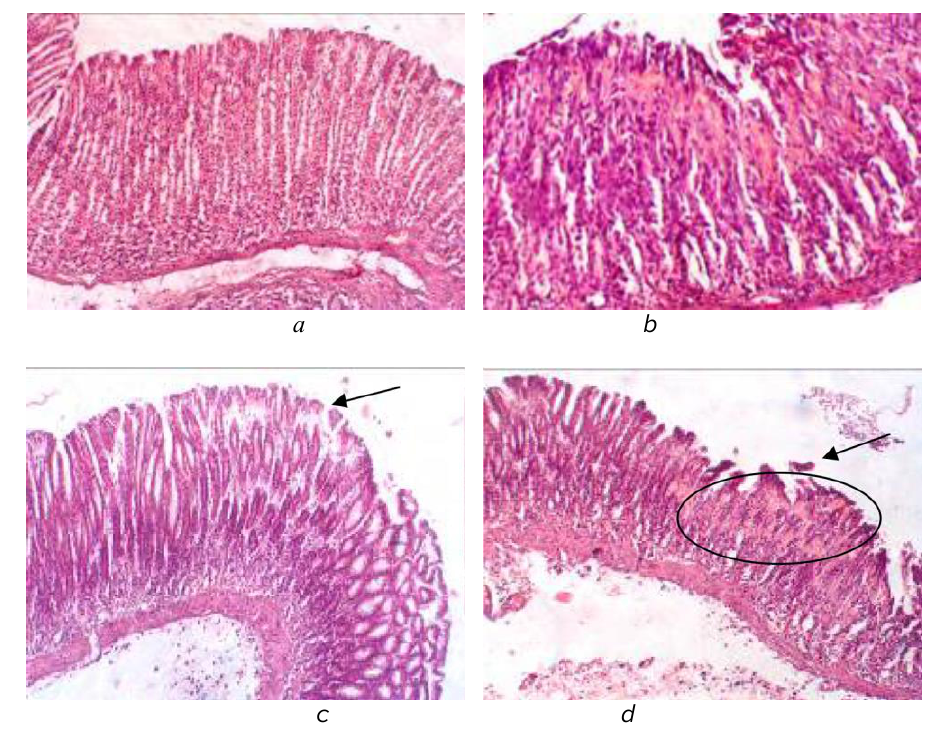
Fig. 14. The stomach of rats with administered Altan at a dose of 1 mg/kg on the background of an alcohol- prednisolone mixture: a – normal histostructure in the prepyloric section; b – focal stromal edema in the pyloric section; c – hemorrhages with a violation of the mucous membrane structure in the prepyloric; d – pyloric parts. Hematoxylin- eosin. ×100